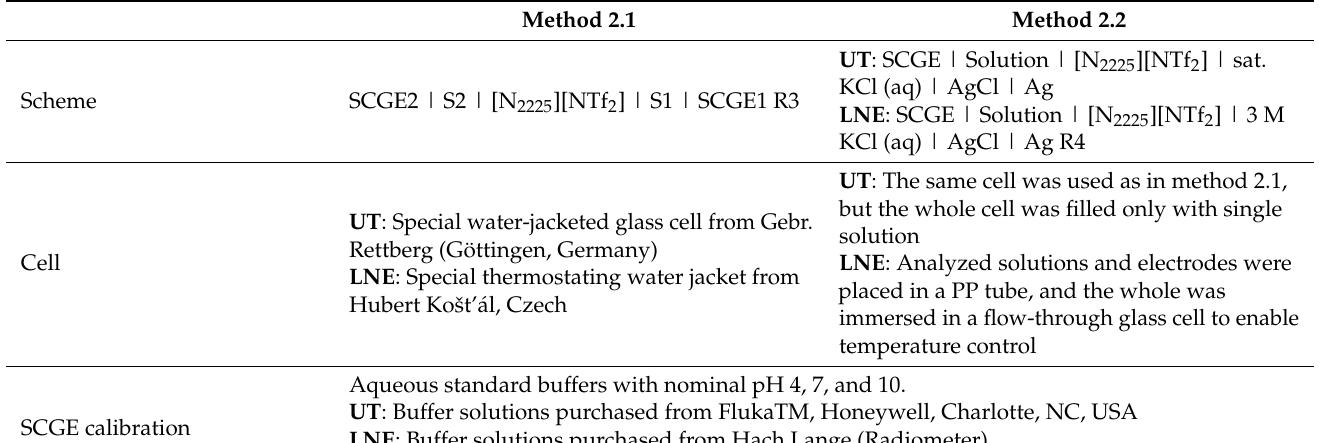
Table 2. Detailed summary of measurements configurations implemented by UT and LNE. Method 2.1 Method